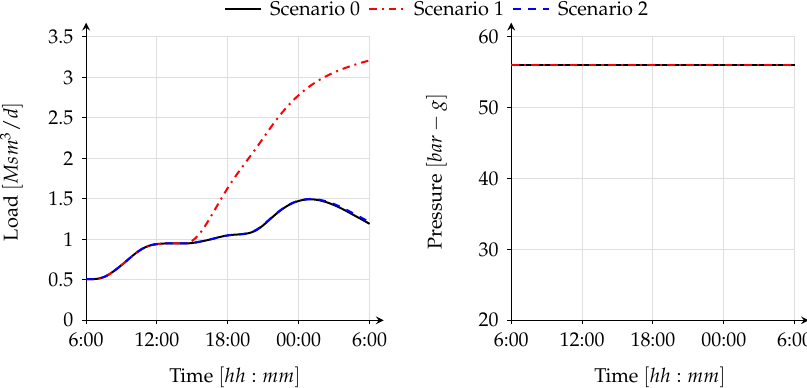
Figure 12. Time evolution of withdrawal rate and pressure at underground gas storage (UGS) facility for the computed scenarios.